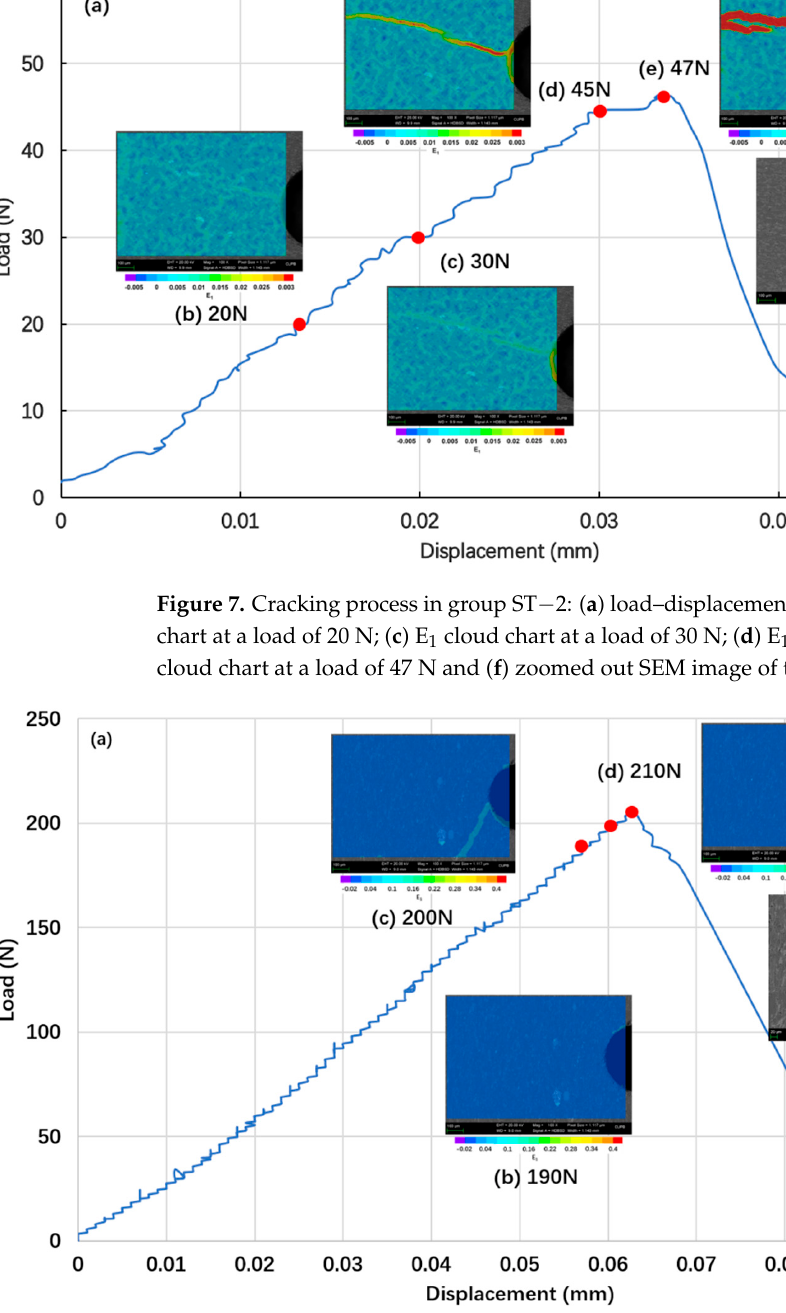
Figure 8. Cracking process in Group A − 1: ( a ) load–displacement curve for Group A − 1; ( b ) E 1 cloud chart at a load of 190 N; ( c ) E 1 cloud chart at a load of 200 N; ( d ) E 1 cloud chart at a load of 210 N and ( e ) zoomed out SEM image of the crack.